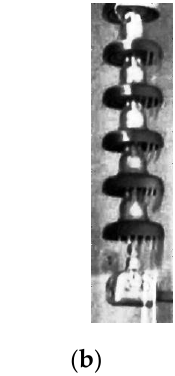
Figure 4. The image with noise interference and the image after median filtering processing. ( a ) The image with noise interference. ( b ) The image after median filtering processing.